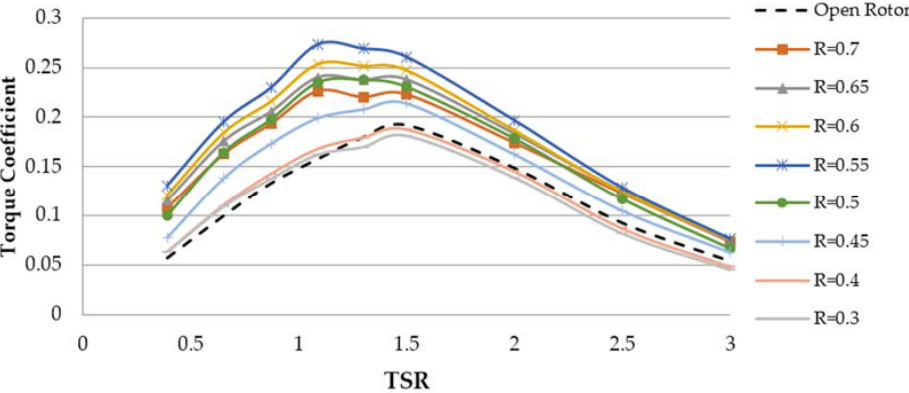
Figure 28. Average torque coefficient versus TSR for different shape ratios of the ODGV.